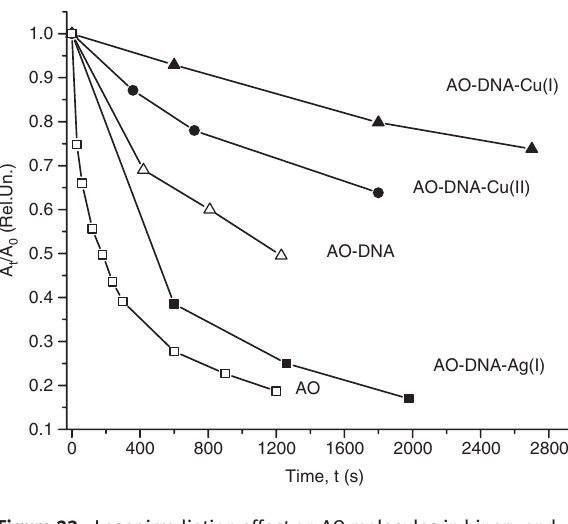
Figure 23 Laser irradiation effect on AO molecules in binary and ternary complexes AO-DNA, AO-DNA-Cu(II), AO-DNA-Cu(I), DNA- AO-Ag, and AO. ▸—AO-DNA-Cu(I); •—AO-DNA-Cu(II),  —AO-DNA,  —DNA-AO-Ag(I) □—AO. [DNA] – 0.7 × 10 -3 mol/l (P), [AO] – 0.7 × 10 -4 mol/l, [EB] – 0.7·10 -4 mol/l, [AA] – 1.4 × 10 -4 mol/l, [Ag + ] – 0.7 × 10 -4